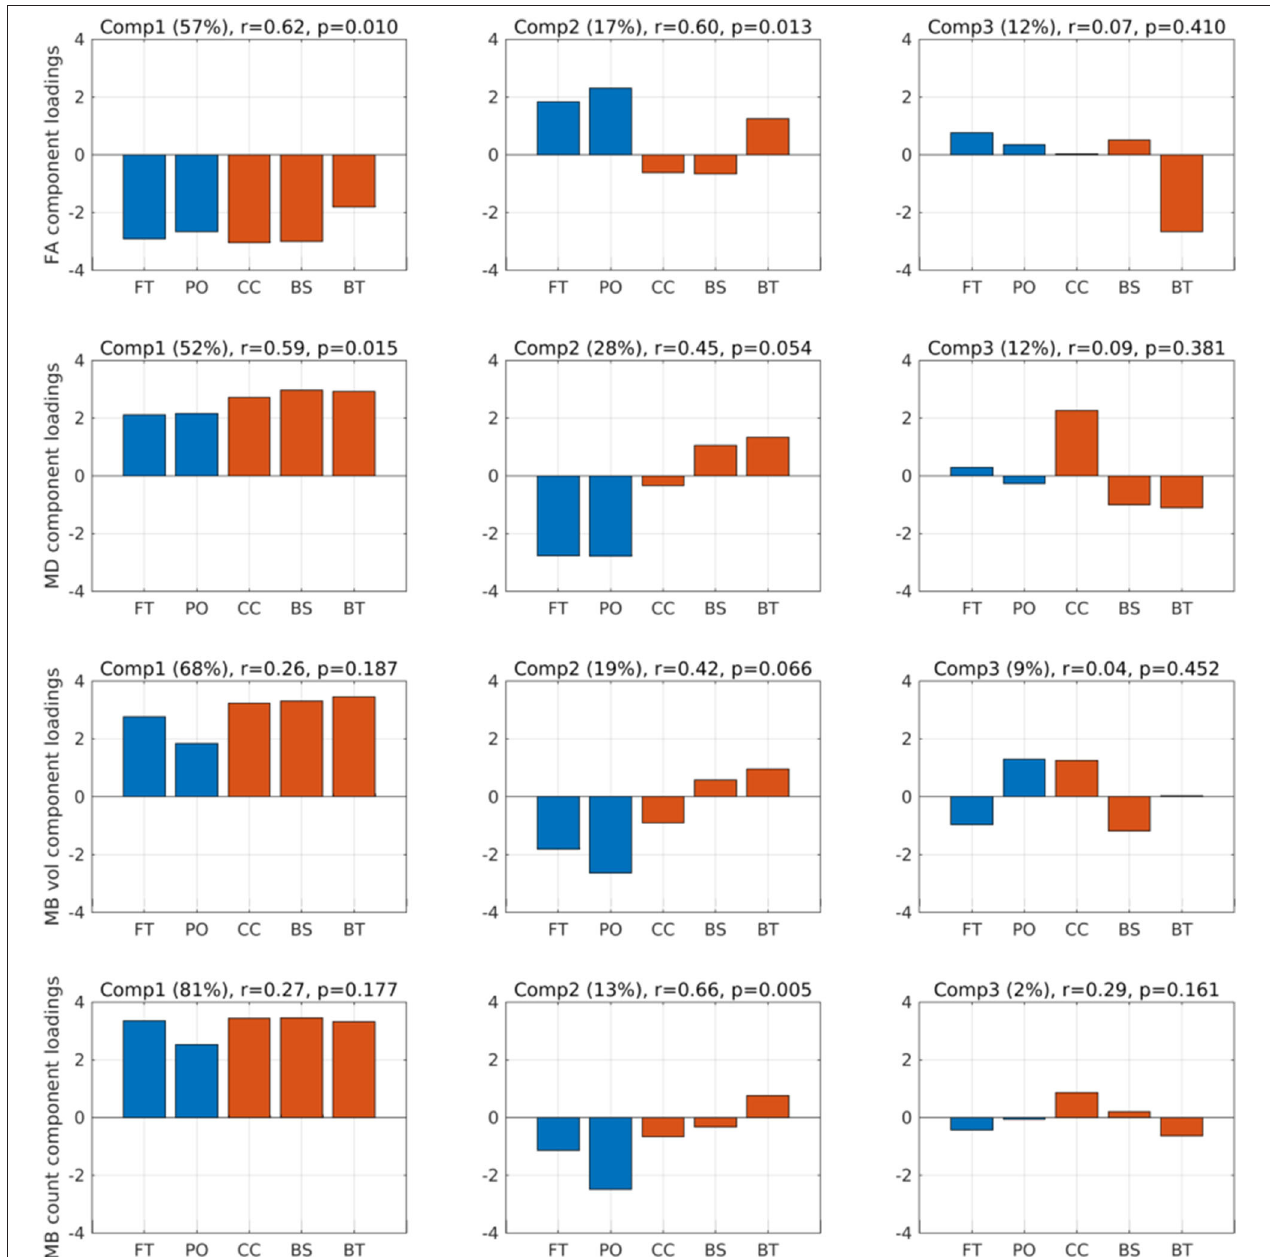
FIGURE 2 | Component loadings. Component loadings (Comp) for the two partial least squares regression analyses predicting post-traumatic amnesia (PTA) using fractional anisotropy (FA) (first row) and mean diffusion (MD) (second row). Above each plot is noted the percentages in parentheses of FA and MD variation explained by the respective components, Spearman r correlation and p value between the component scores and PTA. Red-colored bars are the deep mesial brain regions, and the blue-colored bars are the hemispheric brain regions. FT, fronto-temporal region; PO, parieto-occipital region; CC, corpus callosum, cingular and subcingular WM; BS, brainstem (pons, midbrain, and medulla); BT, basal ganglia (caudate, putamen, and pallidum) and thalamus.